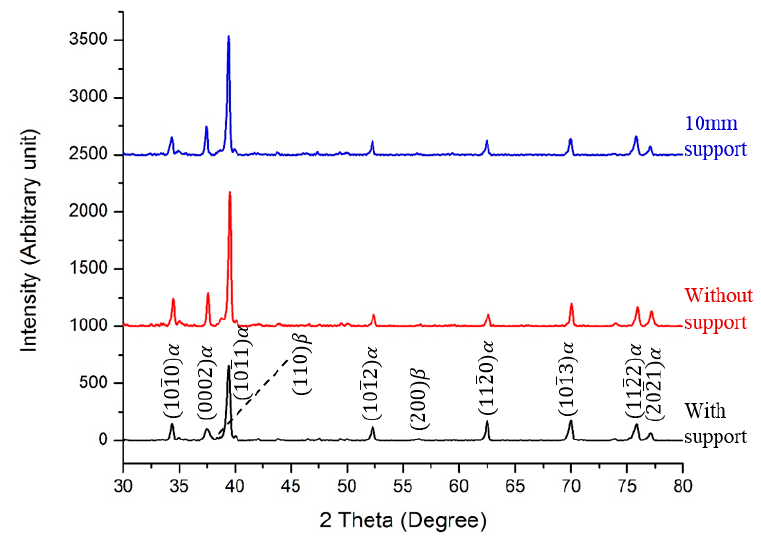
Figure 23. XRD peak analysis of the 30-mm-diameter, 5-mm-thick samples built with support, without support, and with 10-mm critical support.